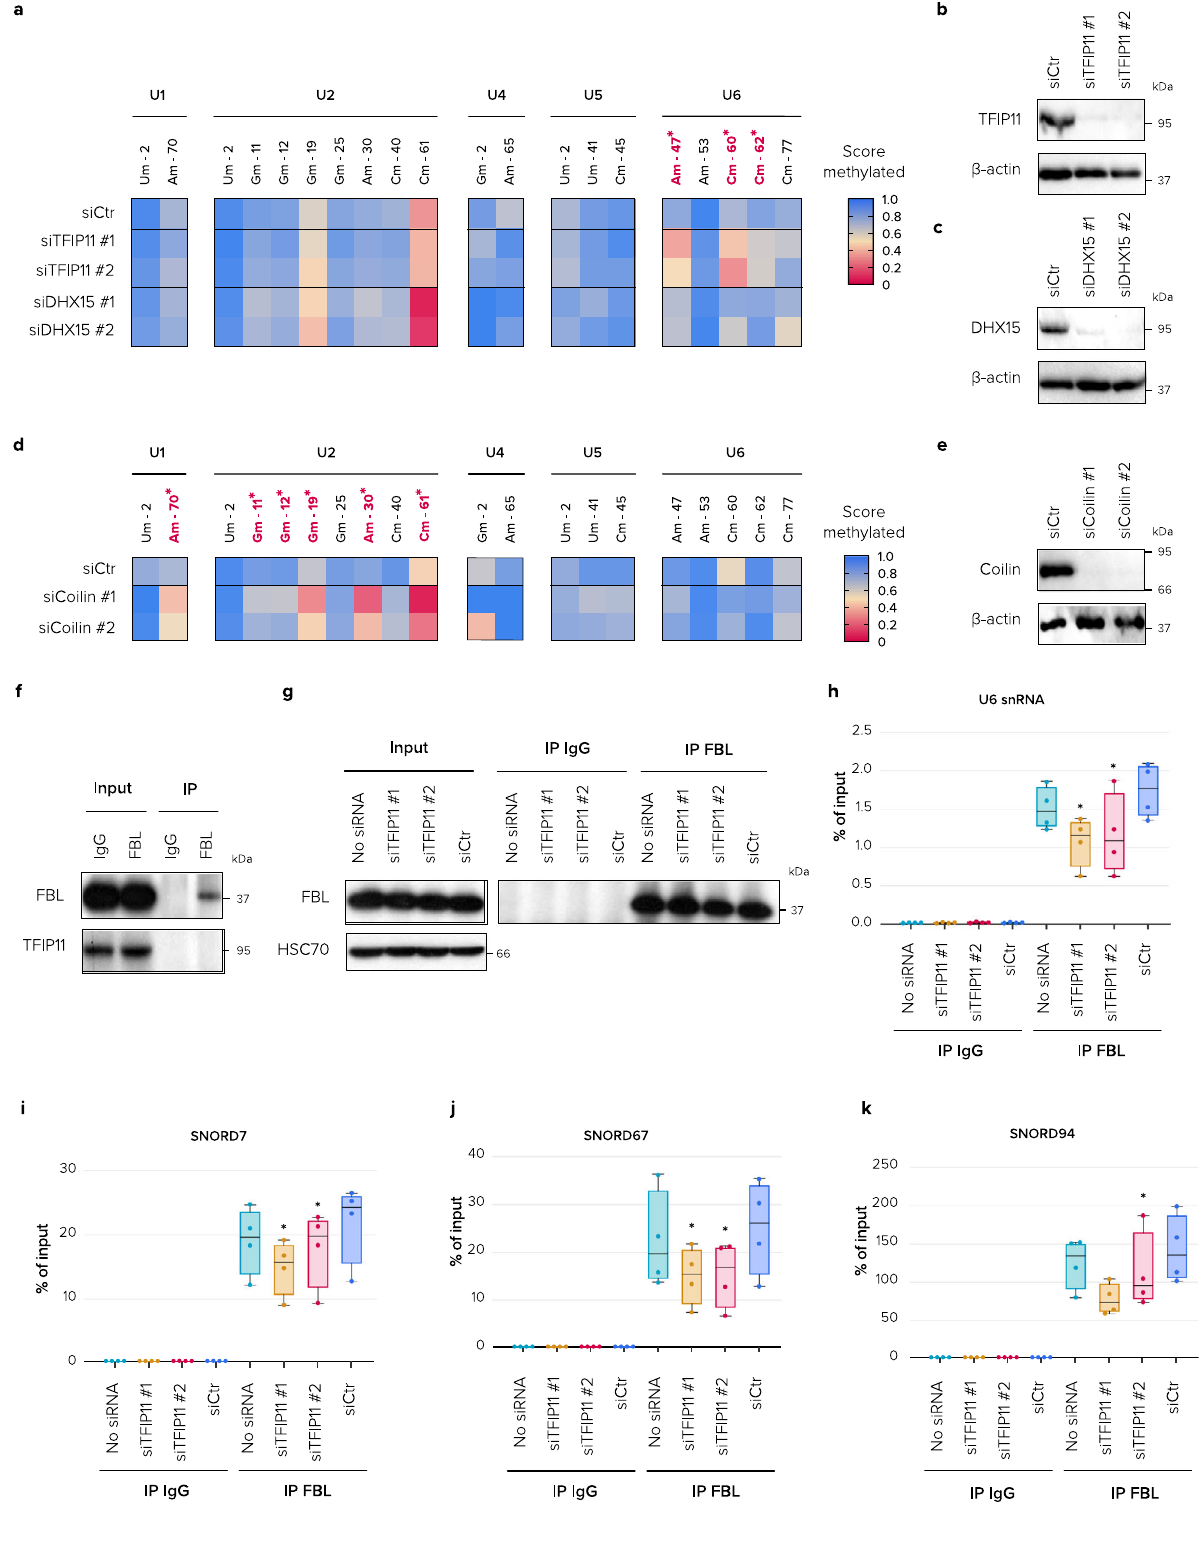
Methods Cell culture . HeLa (ATCC, #CCL-2), HCT116 (ATCC, #CCL-24), A549 (ATCC, #CCL-185) and MDA-MB-231 (ATCC, #HTB-26) cancer cell lines were main- tained in Dulbecco ’ s Modi fi ed Eagle ’ s Medium (Lonza). U2OS cells (ATCC, #HTB- 96) were maintained in McCoy ’ s 5A Medium. All media were supplemented with 10% heat-inactivated fetal bovine serum, and cells were incubated at 37 °C in the presence of 5% CO 2 . All cell lines were characterized by ATCC. All cells were